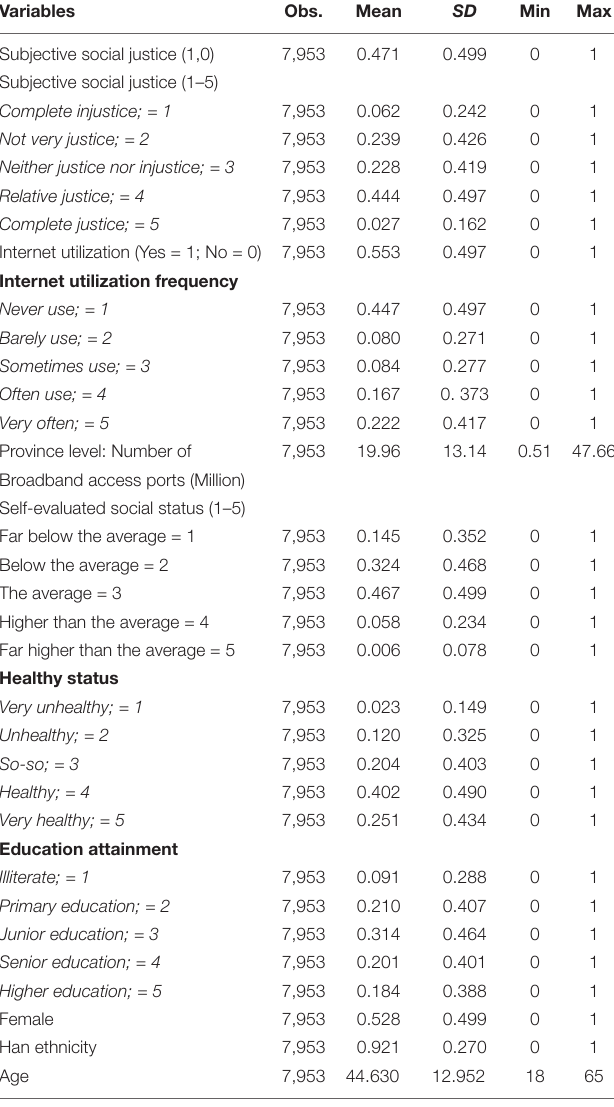
TABLE 1 | Summary of main descriptive